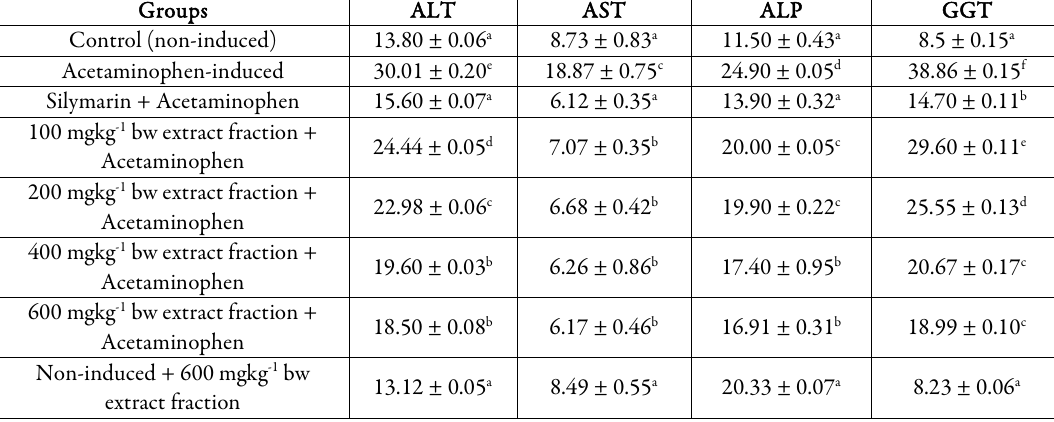
Values are expressed as Mean ± SEM (n = 4). Values along the column with different superscripts are significantly different (P < 0.05) Table 4. Bilirubin concentration (mg//dl) in serum of the rats Groups